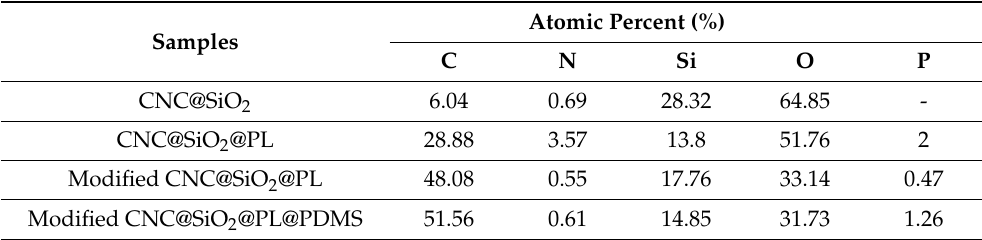
Table 1. Atomic ratio of elements in the CNC@SiO 2 coating, CNC@SiO 2 @PL coatings before and